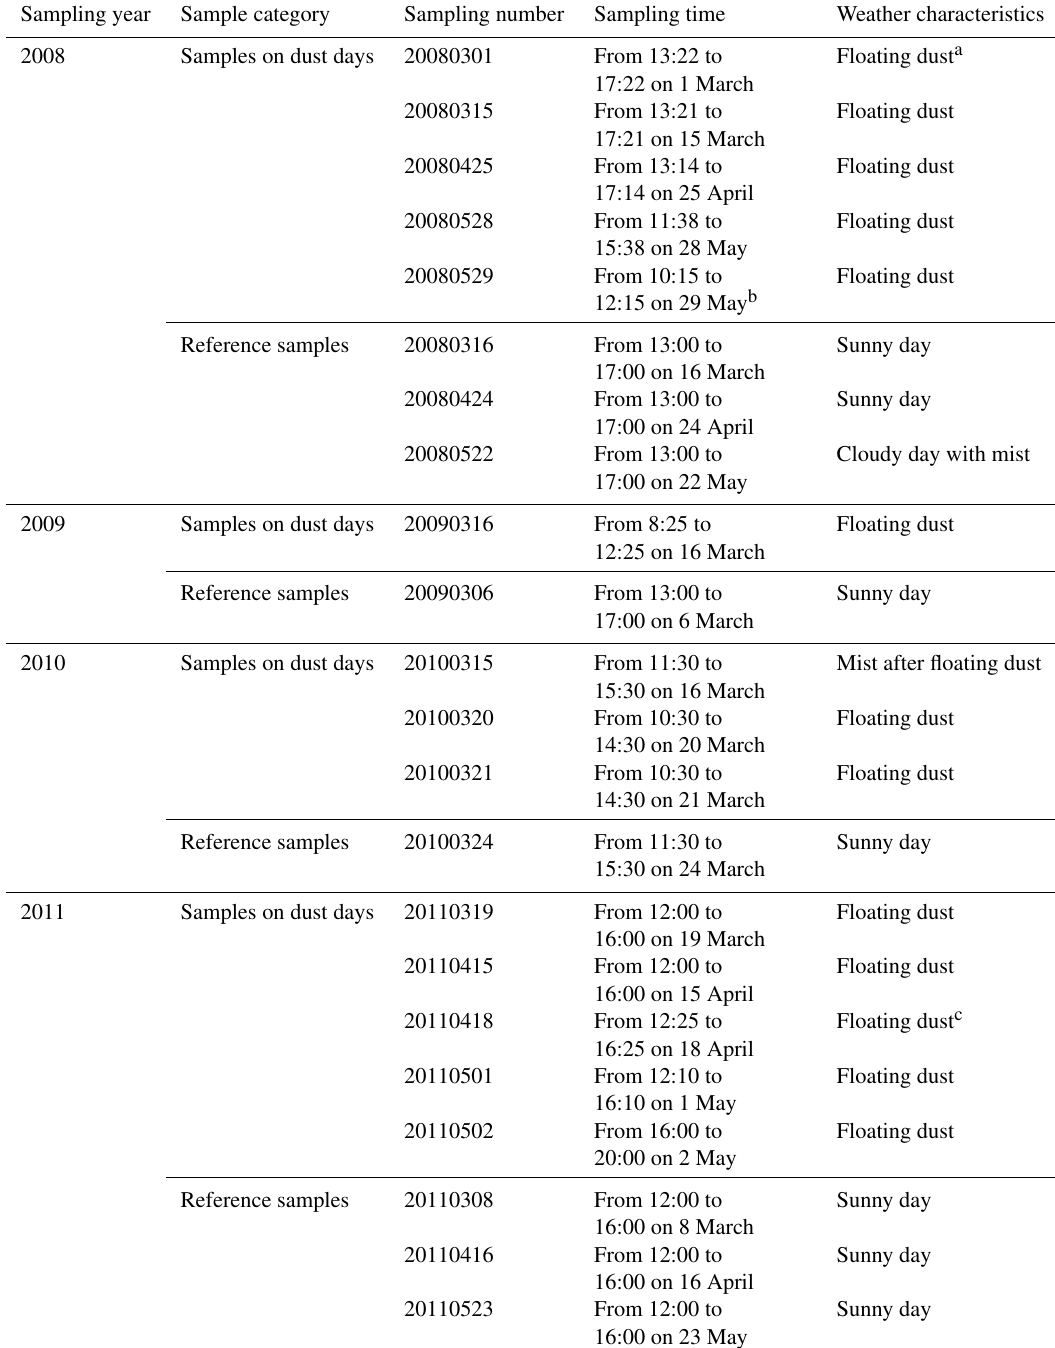
Table 1. Sampling information for the aerosol samples collected at the Baguanshan site in the coastal region of the Yellow